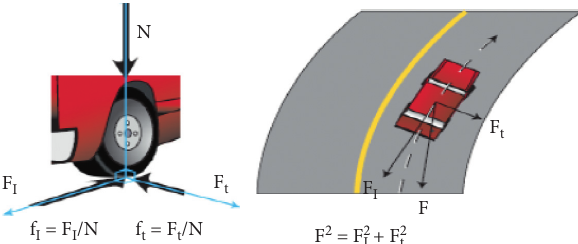
Figure 2: How the frictional force gets applied on the contact surface of rubber and pavement